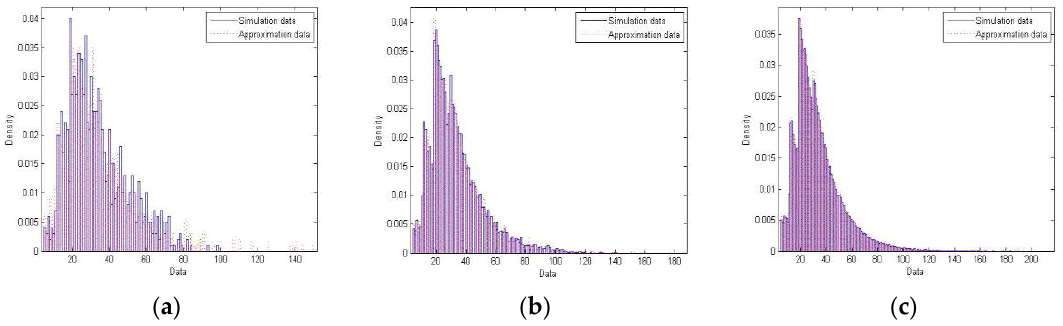
Table 4. The probability mass function of random variable K for our third example.